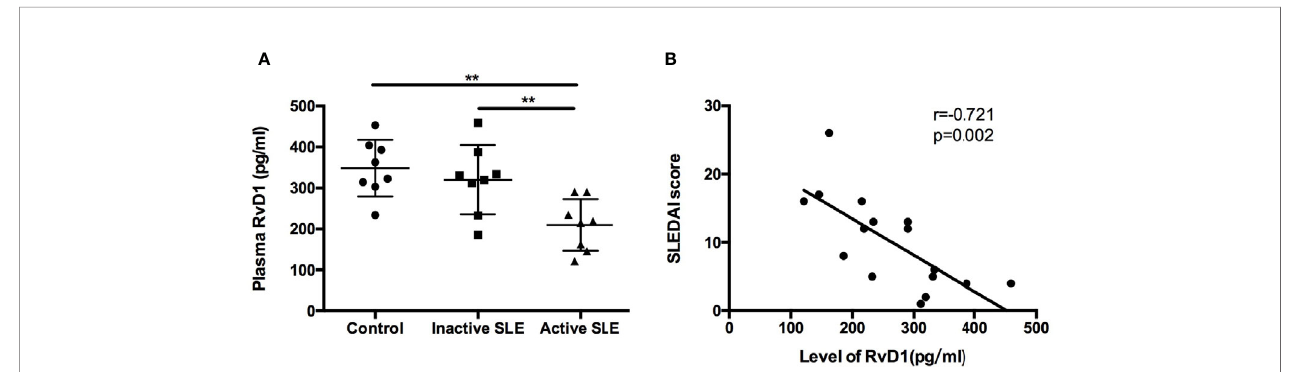
FIGURE 1 | Plasma RvD1 level in SLE patients. (A) The levels of RvD1 in plasma samples from healthy controls, patients with inactive and active SLE (n=8 per group). (B) The SLEDAI score had a signi fi cant negative correlation with RvD1 level (r=-0.721, p=0.002). All data are mean ± SEM. ** p <